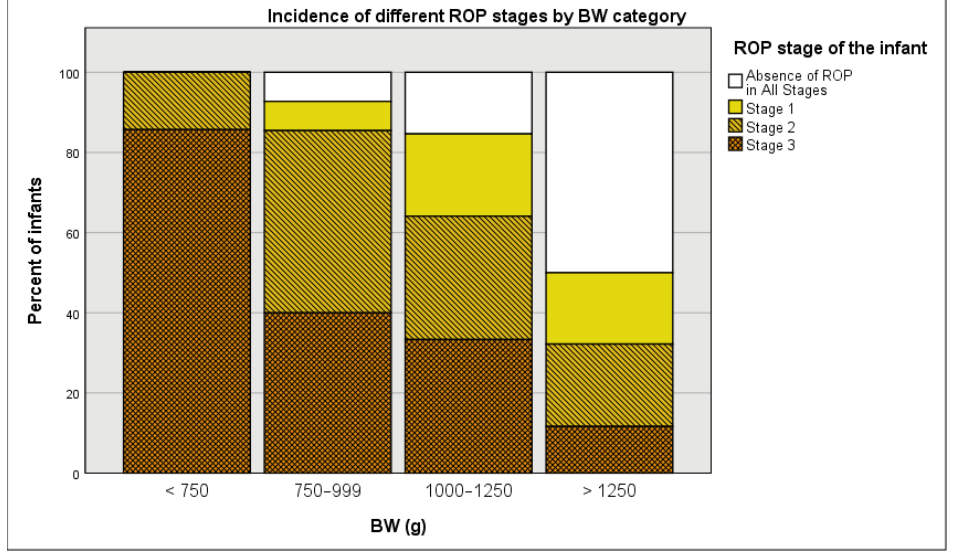
Figure 3. Percent incidence of various ROP stages stratified by BW groups (<750, 750–999, 1000–1250, and >1250